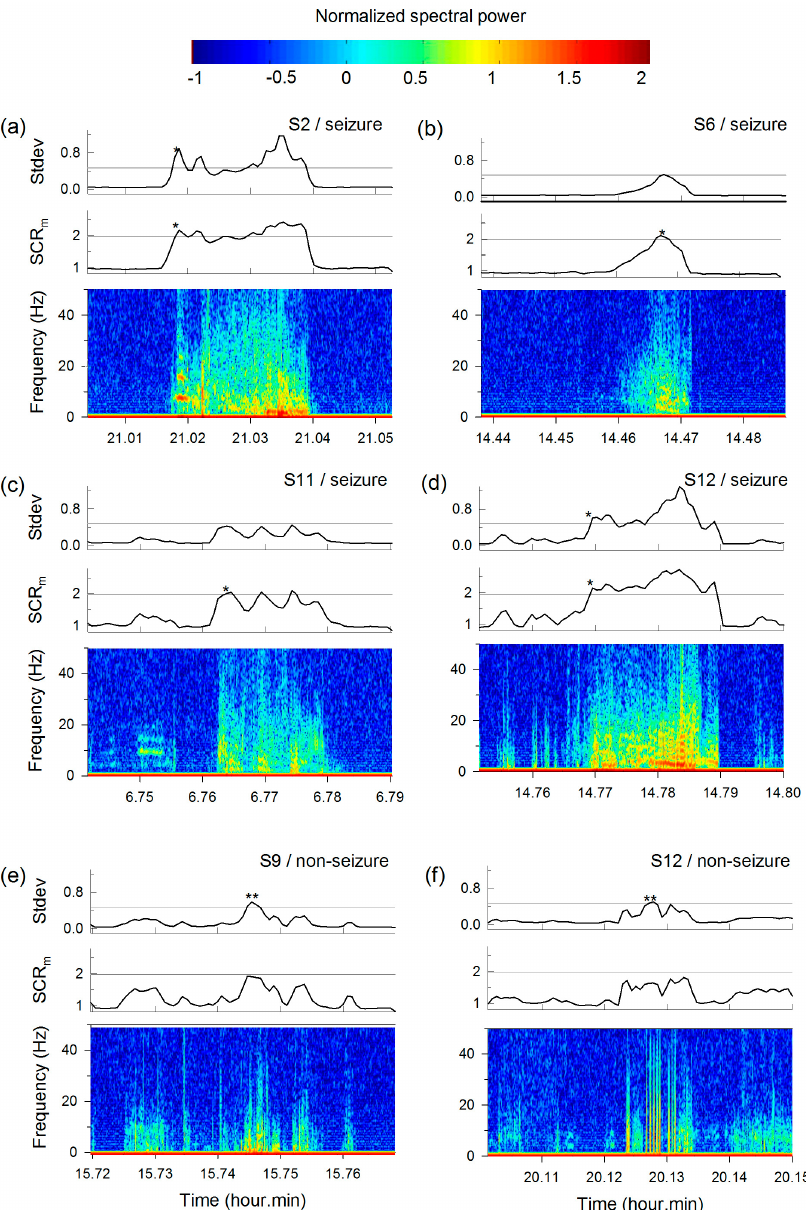
Figure 6. Examples of power spectra during either ( a – d ) seizure events or ( e , f ) normal movements. The SCR and Stdev of the ACM data are plotted as a function of recording time. ‘*’ and ‘**’ denote the true positives and false positives, respectively.